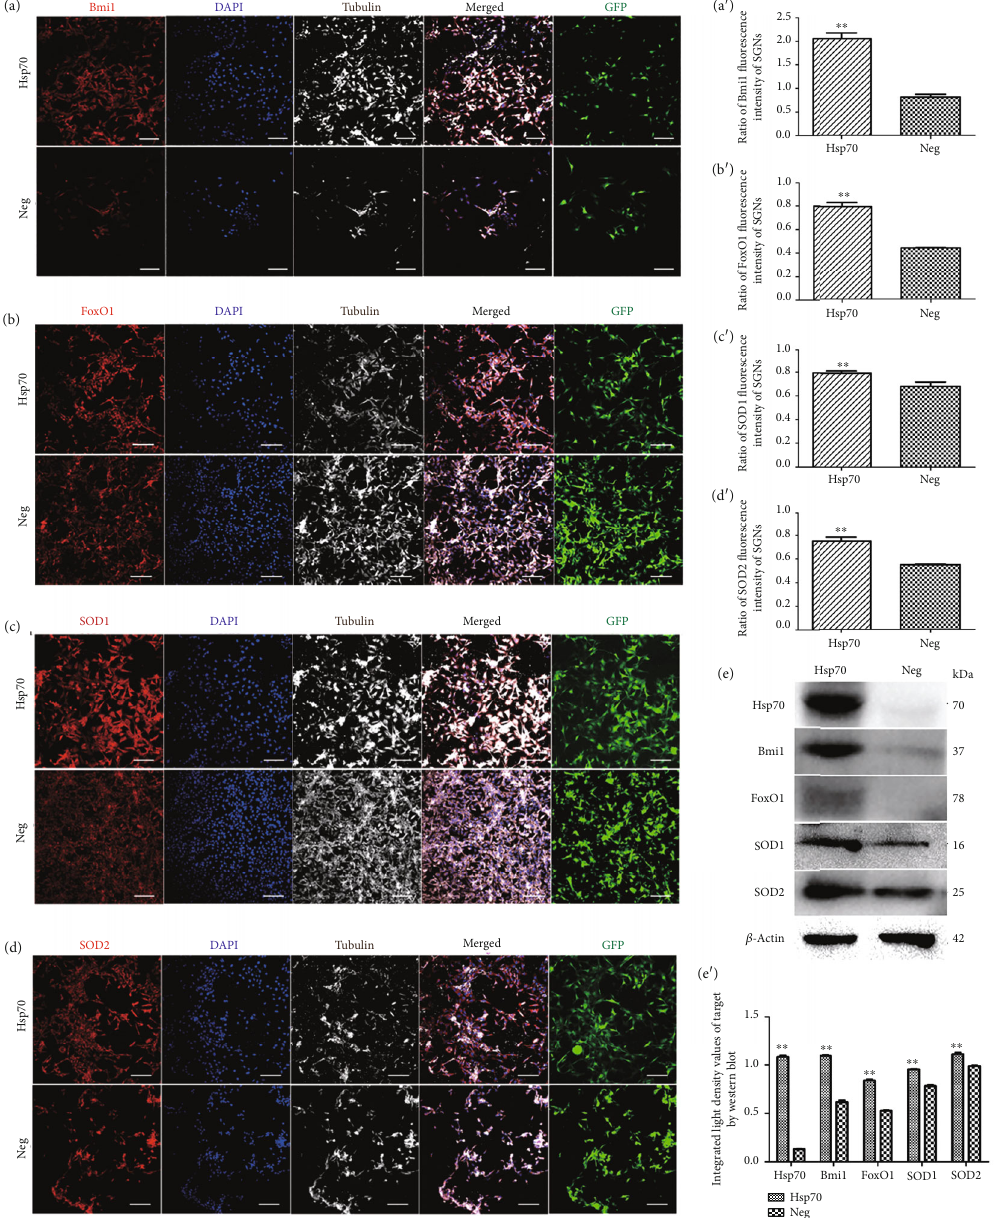
Figure 7: Bmi1, FoxO1, SOD1, and SOD2 expressions of overexpressed HSP70 SGNs. Distributions and expressions of Bmi1, FoxO1, SOD1, and SOD2 protein in SGNs were detected with the immune- fl uorescence assay in the Hsp70-overexpressing adenovirus and negative control groups (a – d), while the quantity of these protein expressions was analyzed by the ratio of fl uorescence intensity (a ′ – d ′ ). After successful transfection by Hsp70-overexpressing adenovirus or empty vector adenovirus as GFP (green) shown, Bmi1/FoxO1/SOD1/SOD2 (red) and tubulin (white) as SGN marker were, respectively, labeled with fl uorescent secondary antibody and nuclei (blue) were labeled with DAPI. Scale bars represent 100 μ m. SGNs expressing a green fl uorescent protein (GFP) coded in the same vector as the Hsp70-overexpressing vector was coupled to the GFP sequence, indicating that 66 : 7 % ± 7 : 8 % ( n = 4 independent cell culture preparations) of the neuronal cells present in the cultures were transfected with Hsp70. Therefore, ratios of Bmi1, FoxO1, SOD1, and SOD2 fl uorescence intensity to GFP were calculated. Furthermore, values are means ± SD ( N = 40 animals from 2 groups). ∗∗ P < 0 : 05 vs. negative group. Statistical analysis of the results presented in (a ′ – d ′ ) was performed with Student ’ s t -test ( ∗∗ P < 0 : 05 ; N = 40 animals from 2 groups). After successful transfection by Hsp70-overexpressing adenovirus or empty vector adenovirus, protein expressions of Hsp70, Bmi1, FoxO1, SOD1, and SOD2 were assessed with western blot (e), while the quantity of these protein expressions was analyzed by integrated light density (e ′ ). β - Actin protein was available as an endogenous control. Furthermore, values are means ± SD . ∗∗ P < 0 : 05 vs. negative group. Statistical analysis of the results was performed with two-way ANOVA (interaction: F ð 4, 20 Þ = 459 .8; P < 0 : 0001 ; row factor: F ð 4, 20 Þ = 493 : 74 ; P < 0 : 0001 ; column factor: F ð 1, 20 Þ = 3400 : 31 ; P < 0 : 0001 ), followed by Student ’ s t -test ( ∗∗ P < 0 : 05 ; n = 12